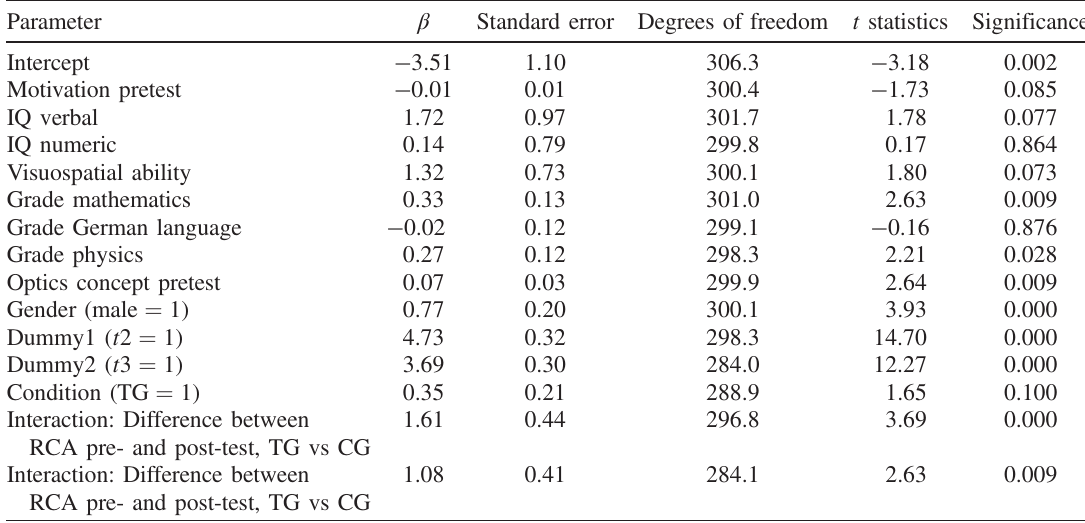
TABLE X. Results of the multilevel analysis for DU assessment items only: influence of variables on students ’ RCA, fixed effects (multilevel model for measuring